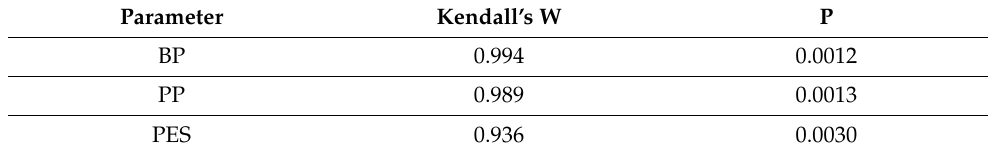
Table 5. Kendall W for radiographic parameters, PES and